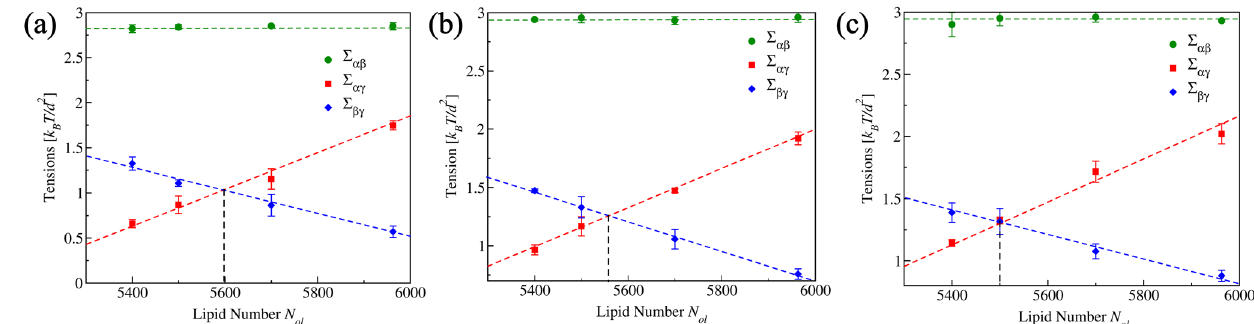
Fig.6|Interfacialtension Σ αβ (greencircles),bilayertension Σ αγ (redsquares)of the membrane segment αγ , and bilayer tension Σ βγ (blue diamonds) of the membranesegment βγ asfunctionsofthelipidnumber N ol intheouterbilayer lea fl et. All nanovesicles have the same volume ν = ν 0 . The data in a – c are obtained forthethreedropletdiameters11.2nm,15nm,and19.6nm,respectively.Eachdata point represents the mean value over n =15 statistically independent samples obtained from three replicated simulations. Each error bar is the SEM. The largest surface tension is provided by the interfacial tension Σ αβ , which is essentially